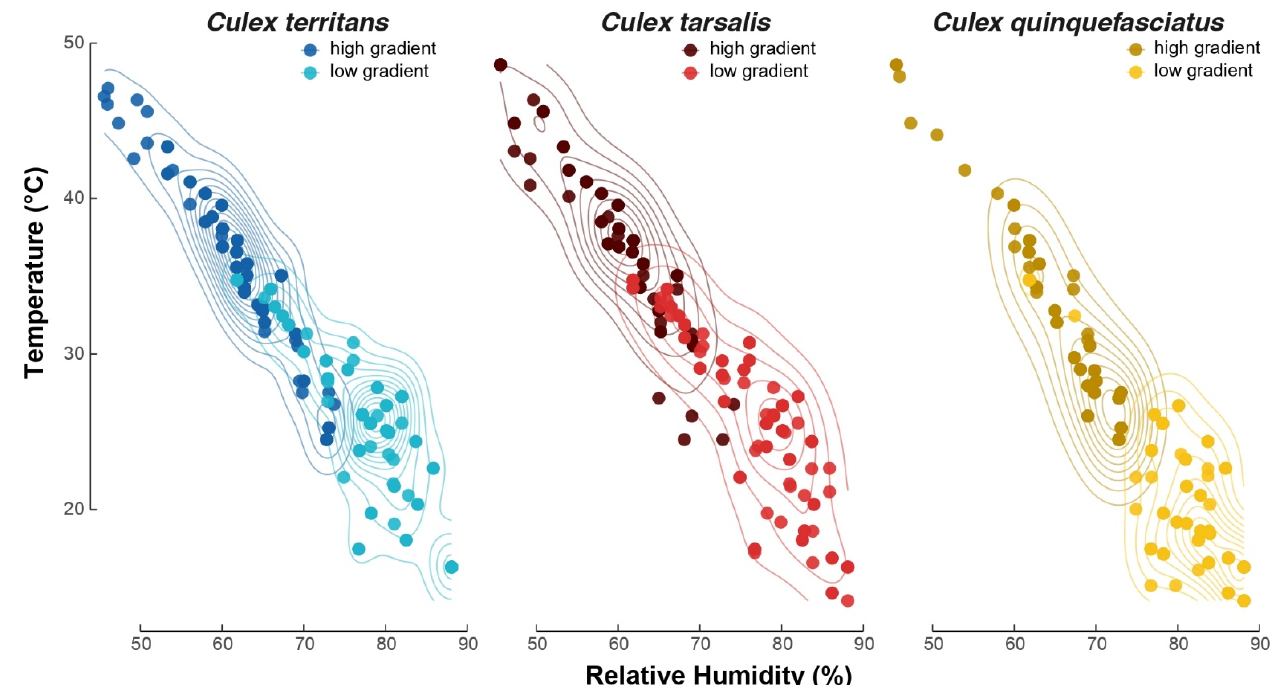
Figure 5. A 2-D density plot representing the temperature and humidity at the final resting position of the three Culex mosquito species on the gradients. Each dot represents a single mosquito. Low and high gradient data are highlighted in light and dark shades, respectively. Ten replicates (n = 10; N = 100) per condition per species have been used.